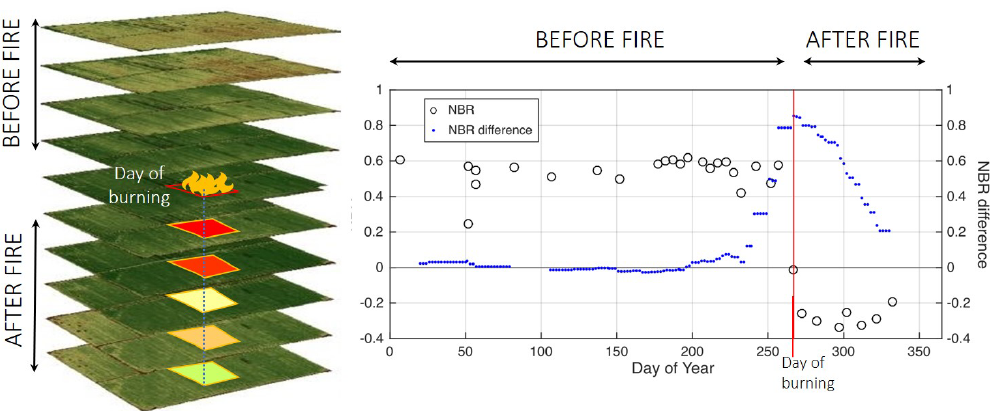
Figure 2. A schematic of Sentinel-2 time-series imagery, associated NBR values (open circles), and NBR differences between average NBR values observed before and after the central day of a 2d moving window (blue dots). A burned pixel (20m × 20m) is represented by a red rectangle on the left. Before fire, the vegetated pixel registers positive NBR values (open circles). The NBR rapidly drops during the fire, and, for a few weeks, the satellite observations show a negative NBR. The day of the year when the NBR difference observed via the moving window reaches a maximum corresponds to the moment NBR dropped (red line). This day marks a decline in the pixel’s vegetation, possibly reflecting a burning event. Over time, the vegetation regenerates (re-greening) and the spectral characteristic of charred vegetation fades. Re-greening can happen within days in the case of savanna grasslands, or within months in the case of forest fires on peatlands.